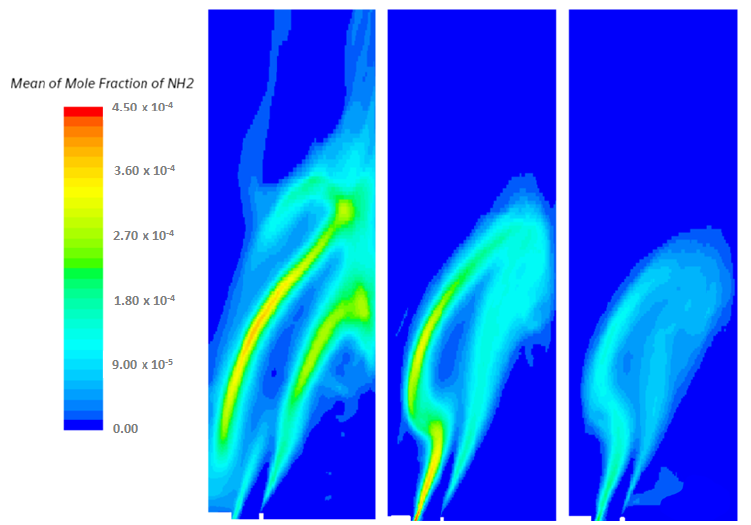
Figure 8. Mean mole fraction of NH2. ( Left ) 20/80; ( Centre ) 40/60; ( Right ) 60/40 (vol%) methane/ammonia blends under stoichiometric conditions.